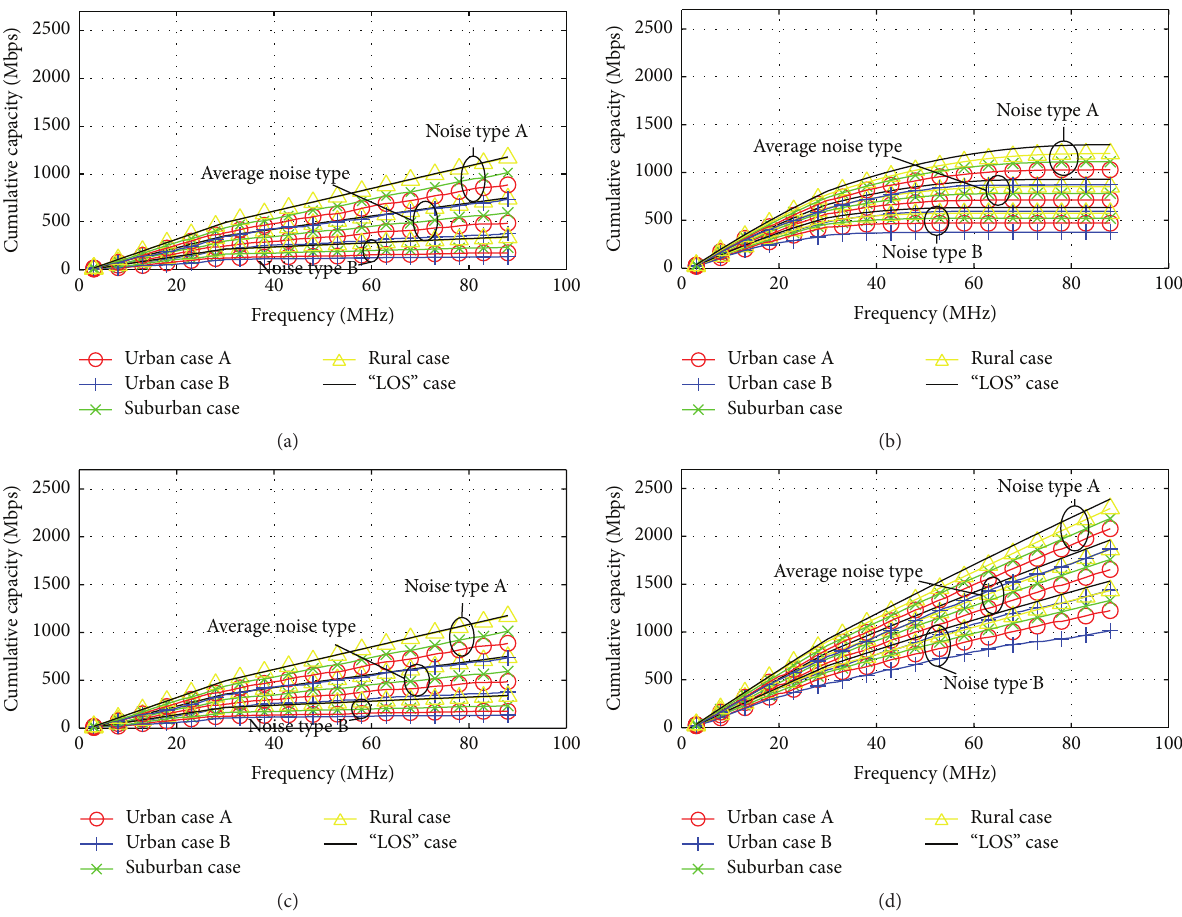
Figure 4: The same as in Figure 3, but for WtW 1 - 2 / PtP 1 - 2 coupling schemes. (a) OV MV / WtW 1 - 2 . (b) UN MV / PtP 1 - 2 . (c) OV LV / WtW 1 - 2 . (d) UN LV / PtP 1 - 2